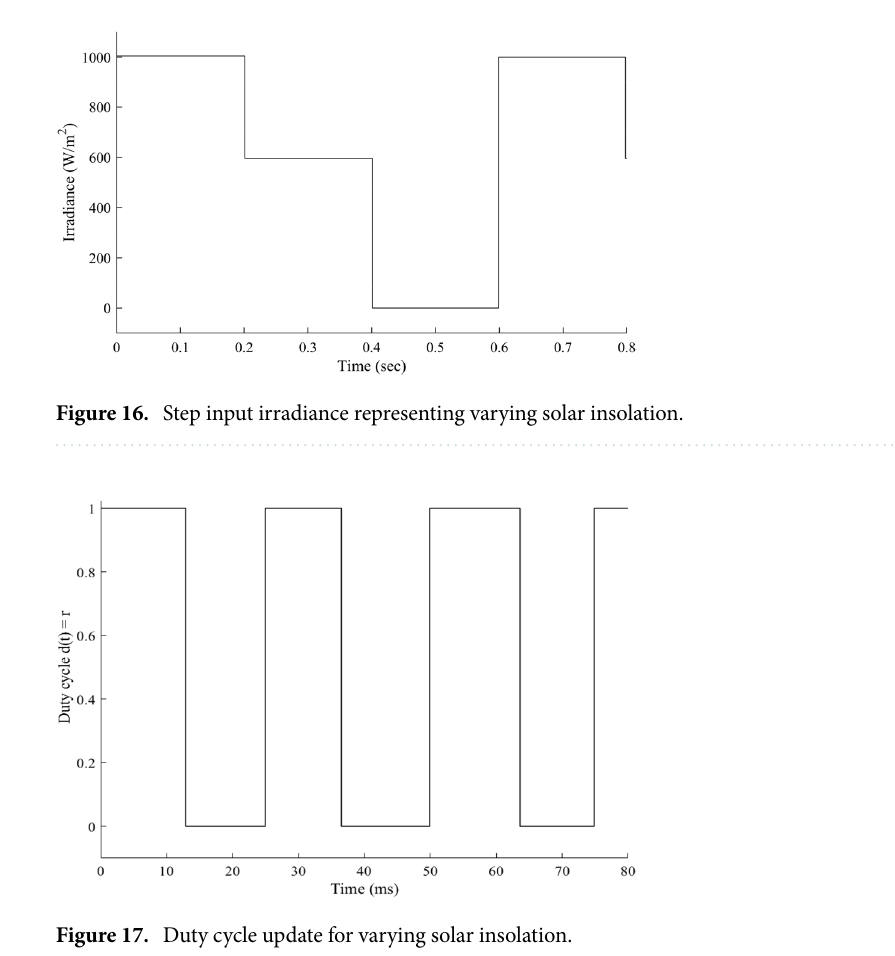
Figure 17. Duty cycle update for varying solar insolation.